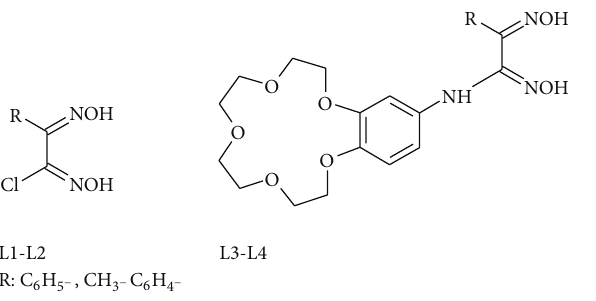
Figure 1: Formula of L1–L4.